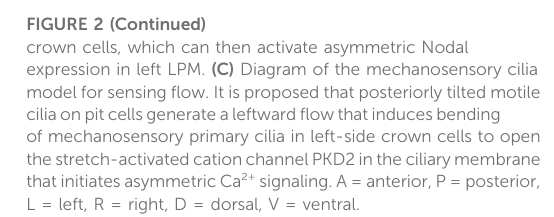
L = left, R = right, D = dorsal, V =